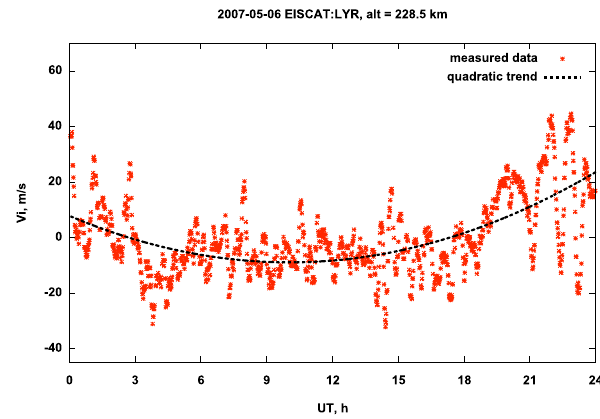
Fig. 4. Field-aligned ion velocity at the altitude 228.5km on 6 May 2007 and the estimated quadratic